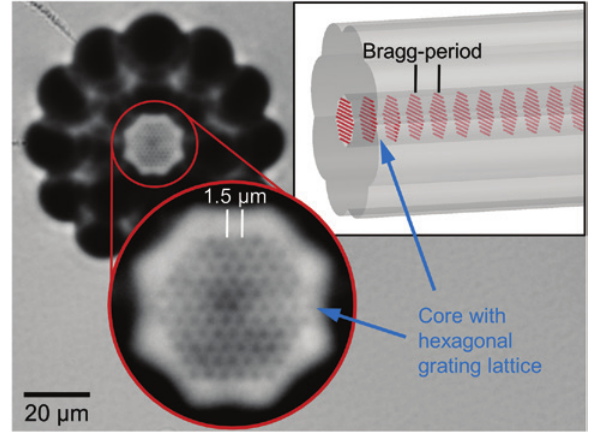
Figure 10: End on, bright-field microscope image of an überstruc- ture WBG revealing the hexagonal lattice of point features within the core of the waveguide.